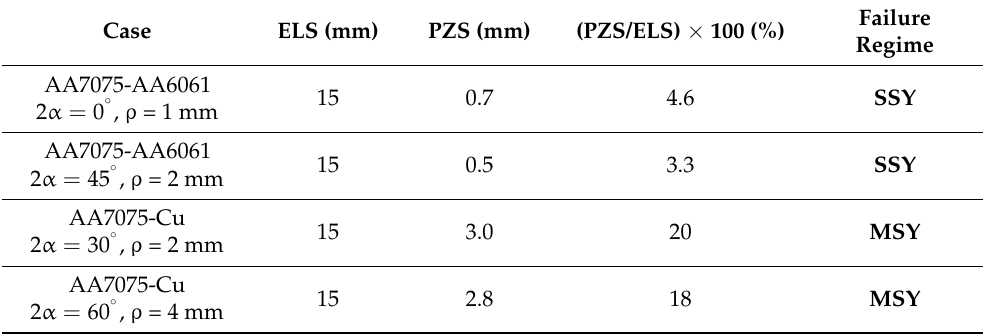
Figure 9. Plastic region around the notch tip for: AA7075-AA6061 weld material with 2 α = 45 ◦ and ρ = 2 mm ( a ); AA7075-Cu weld material with 2 α = 60 ◦ and ρ = 2 mm ( b ). Table 5. Elastoplastic failure regimes for the notched samples made of the FSWed materials. ELS: effective ligament size; PZS: Plastic zone